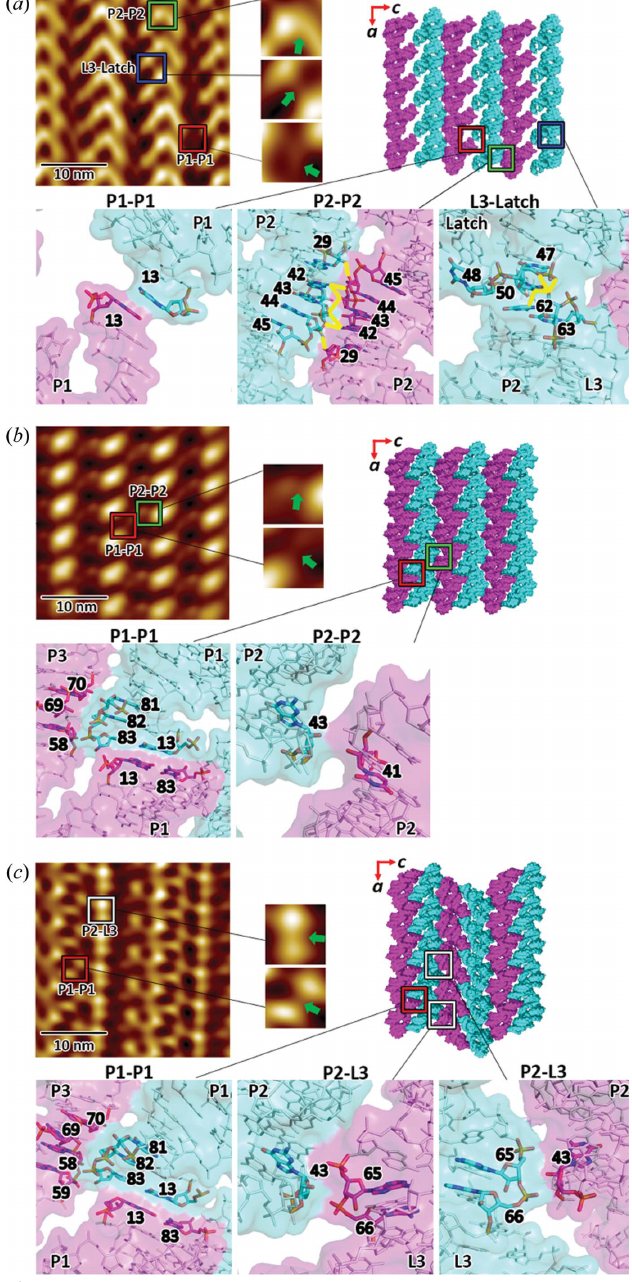
Figure 1 Crystal packing in the ac plane of ( a ) AUC (PDB entry 5e54), ( b ) TUC1 (PDB entry 6vwt) and ( c ) BUC (PDB entry 4tzx), as observed by continuous AFM of the same crystal, and the associated structures determined by X-ray crystallography. The molecular interfaces (P2–P2, P1–P1, P2–L3 and L3–latch) in each phase are highlighted with colored boxes, and respective zoomed-in views are shown. The atomic inter- actions at each interface are shown as sticks with a transparent molecular surface. Hydrogen-bond interactions are drawn as yellow lines. The unit- cell dimensions derived from X-ray diffraction or AFM are listed in Tables S3 and S4. AFM images are 30 (cid:8) 30 nm in size and 0.5 nm in height (dark-to-light color scale). Ligand concentrations for AFM and TRX experiments were 0.15 m M and 10 m M ,